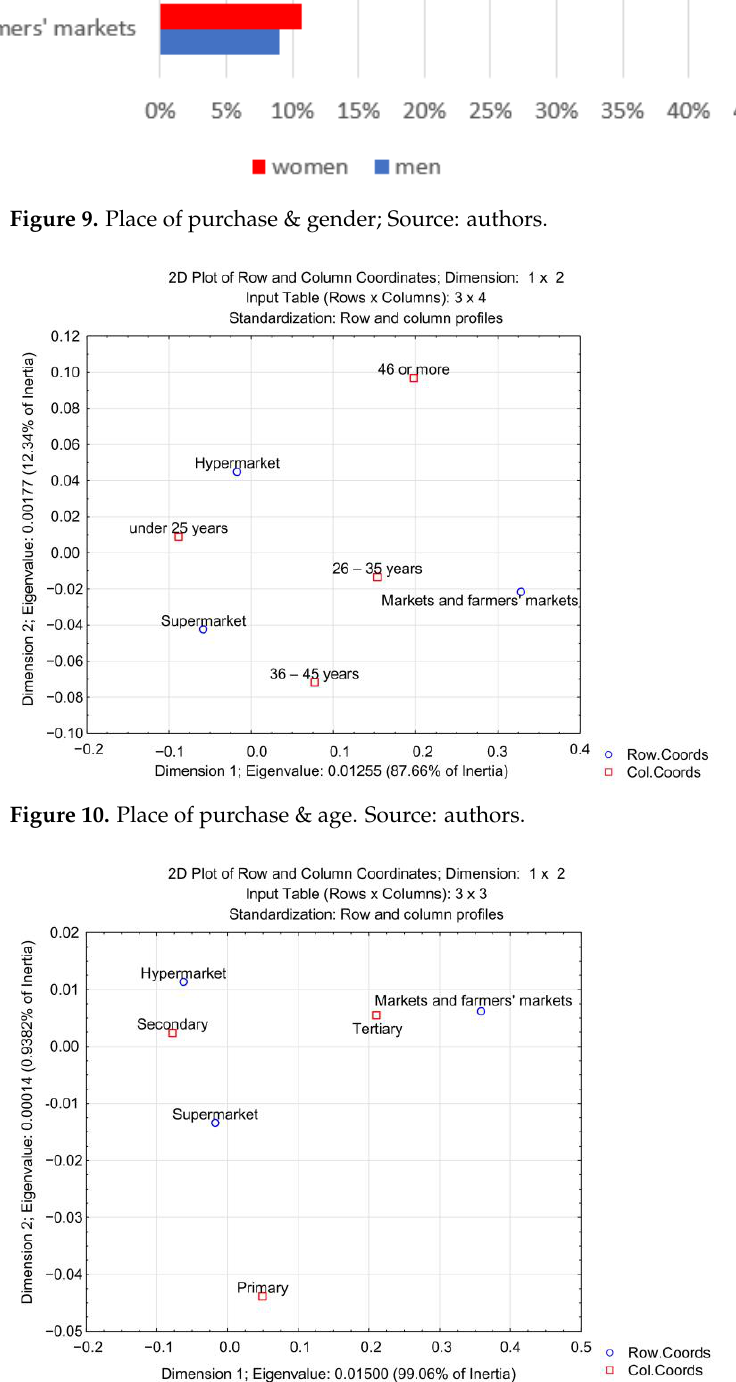
Figure 11. Place of purchase & education. Source: authors.